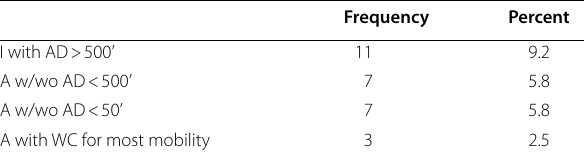
Table 2 SF-36v2 Scale and Summary Measure Scores, Norm-Based Scoring